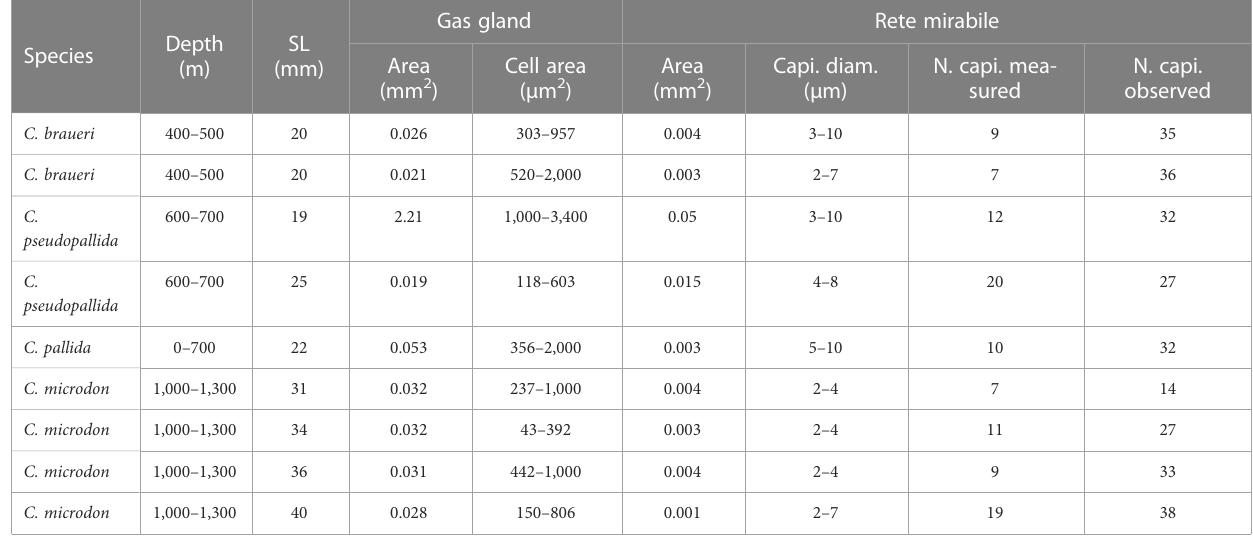
TABLE 3 Size characteristics of gas gland and rete mirabile in four species of Cyclothone ( Figures 7A, B ).